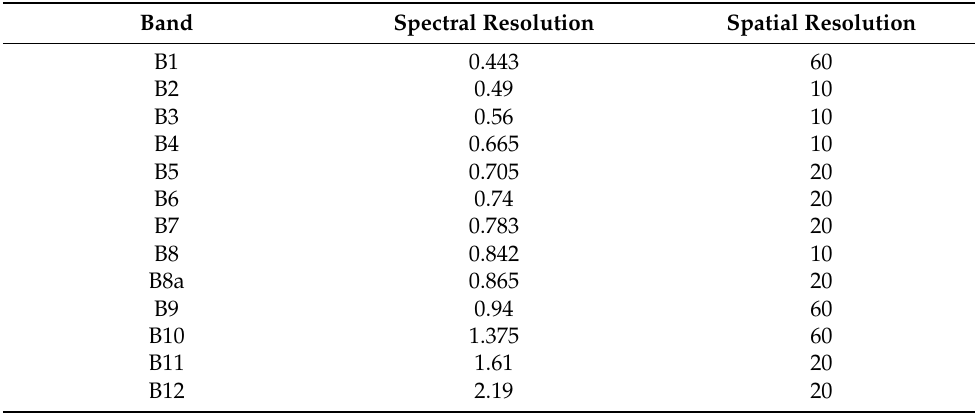
Table A1. Spectral (in microns) and spatial (in meters) resolution of Sentinel-2 sensor.